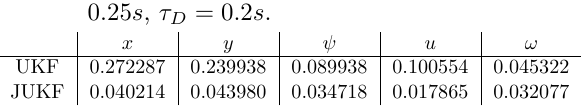
Table 1: RMS errors of the simulation Test 1, τ C =